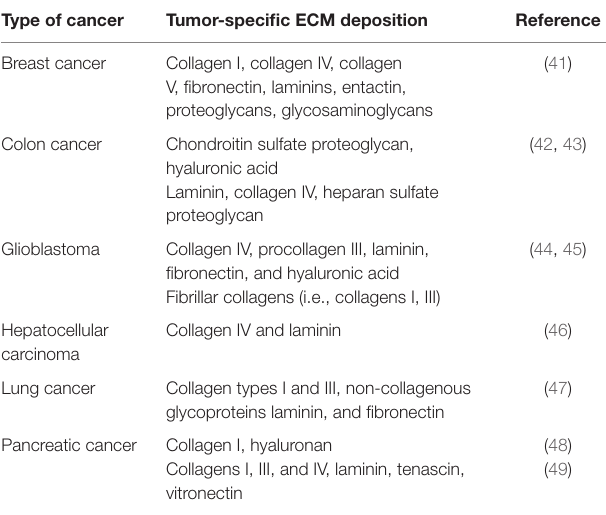
TABLe 1 | Tumor-specific eCM deposition for common types of